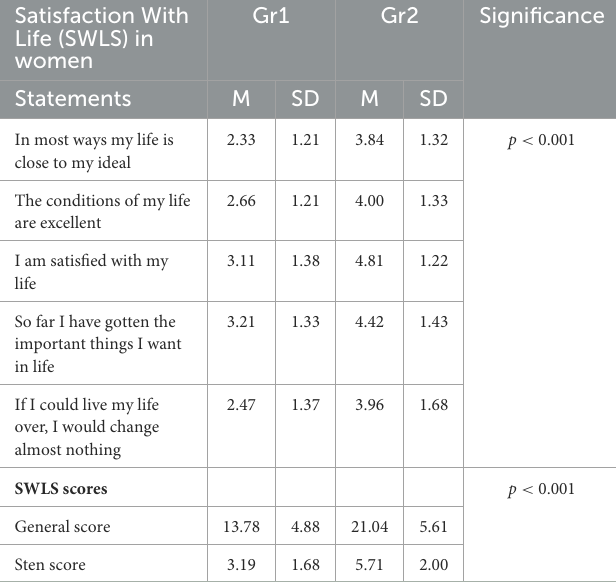
TABLE 3 Causes, forms, and perpetrators of domestic violence experienced by participants in Gr1.